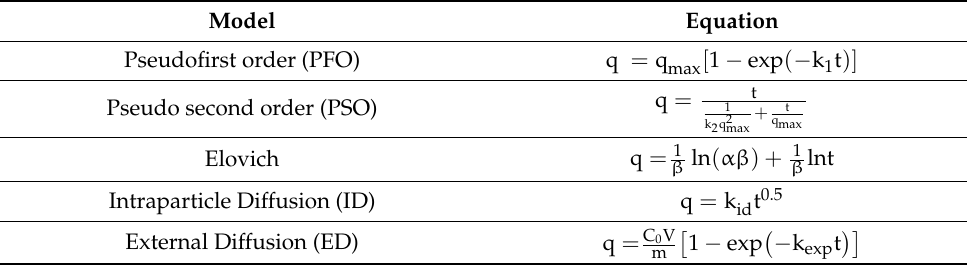
Table 4. Kinetic models of adsorption [40,41].